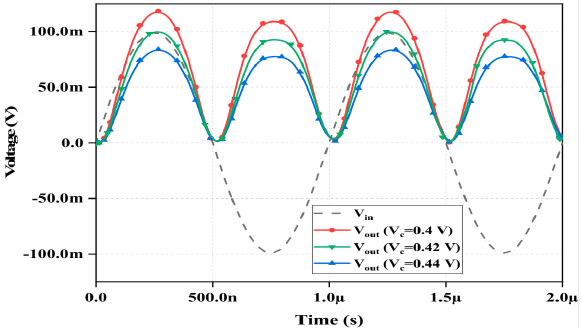
Figure 8. Transient response at frequency f = 1 MHz and V P = 100 mV considering Variable V C